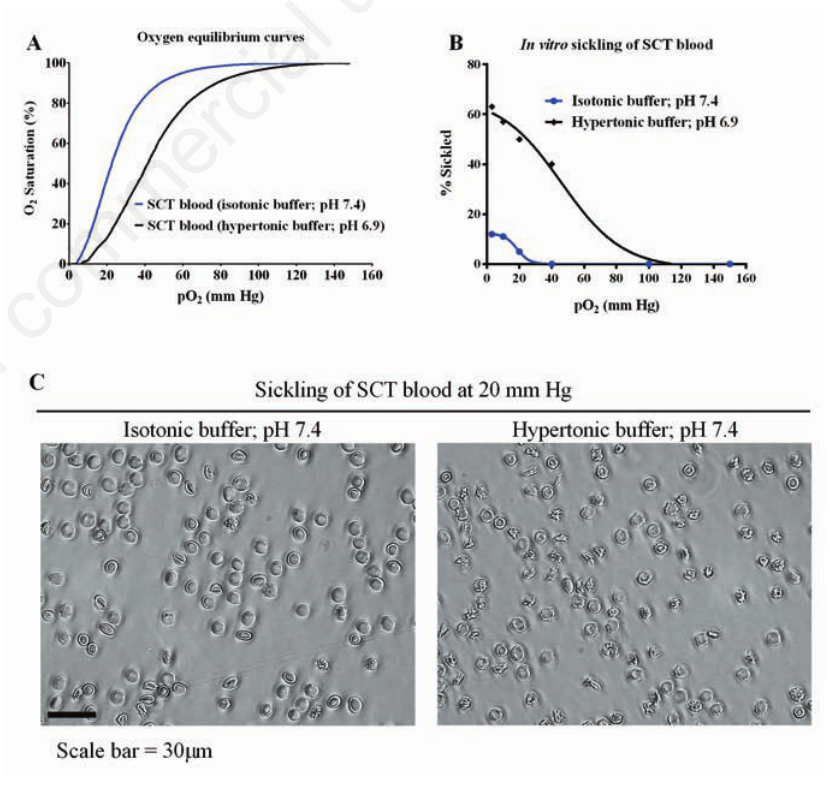
Figure 4. Sickle cell trait (SCT) red blood cells (RBCs) sickle more frequently under con- ditions mimicking a combination of hypoxia, dehydration and acidosis in vitro. A) Oxygen equilibrium curves (OECs) of SCT blood (30% Hct~1.5 mM hemoglobin) in isotonic phosphate buffer (pH 7.4) or hypertonic phosphate buffer (pH 6.9). B) Percentage of SCT RBCs sickled at the indicated oxygen tensions corresponding to the OECs in (A). C) Representative images SCT RBC sickling in isotonic phosphate buffer (pH 7.4) or hypertonic phosphate buffer (pH